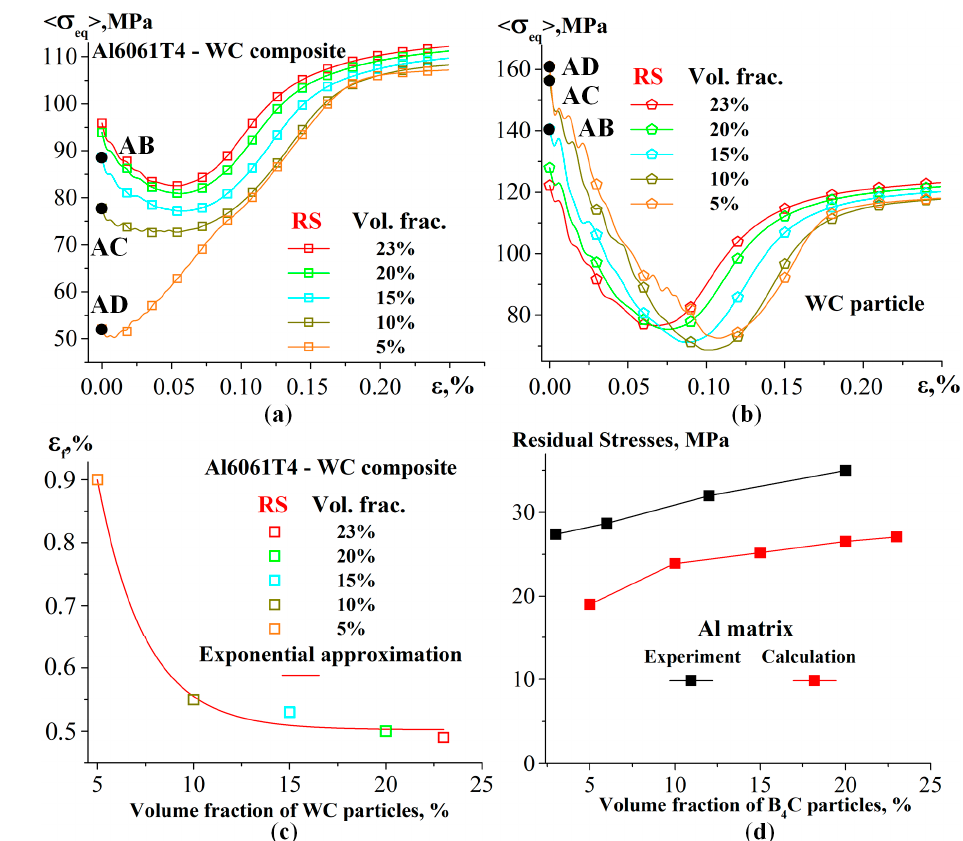
Figure 18. Initial sections of the stress–strain curves of the Al6061T4–WC composites with varying particle volume fractions ( a ), corresponding equivalent stresses averaged over the particle ( b ), elon- gation of the composites at the fracture onset vs. the particle volume fraction ( c ) and a comparison of the experimental and calculated cooling-induced equivalent stress averaged over the Al matrix depending on the B 4 C particle volume fraction ( d ).